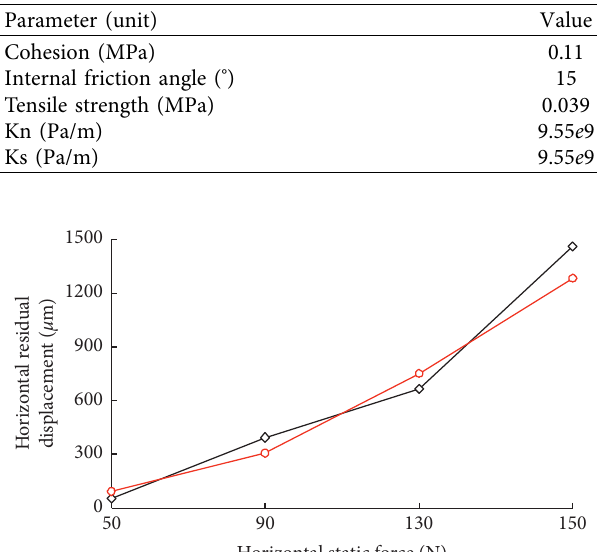
Table 2: Mechanical parameters of the contact surfaces.